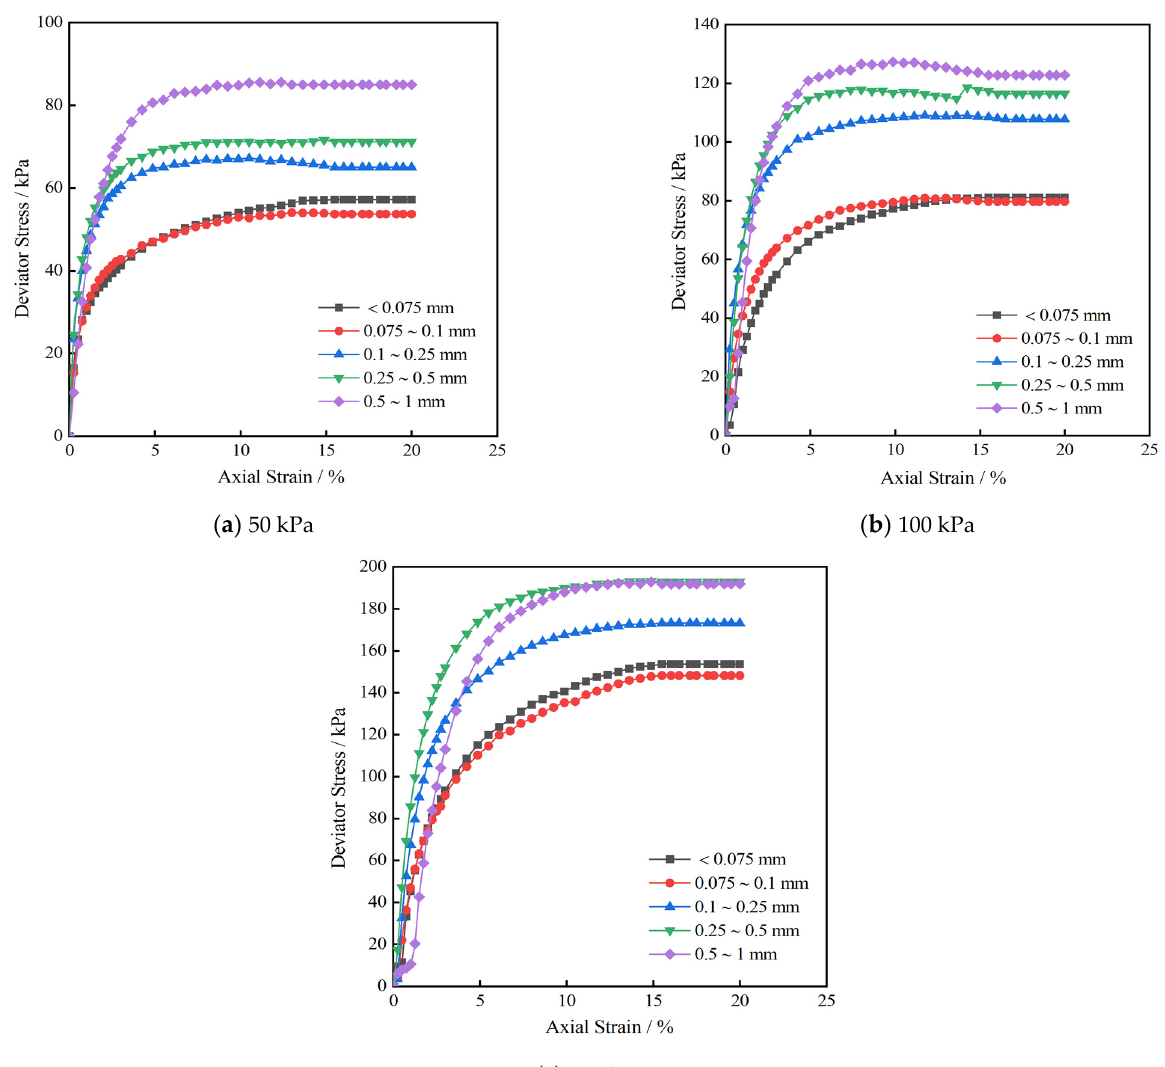
Figure 10. Stress–strain curve.(under different grain groups).